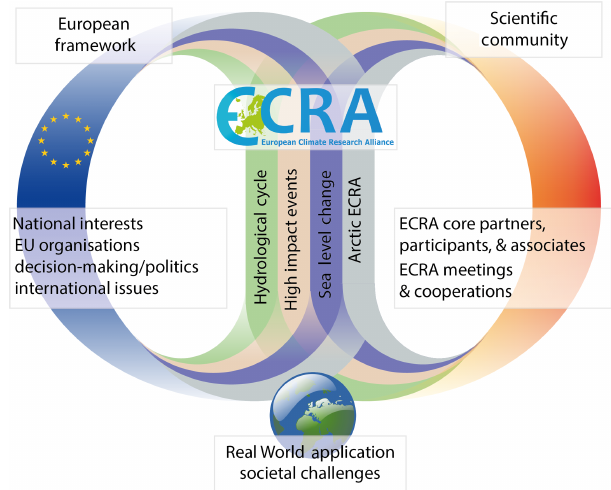
Figure 1. The interplay of ECRA, the European framework, and the scientific actorscape. ECRA’s function is to connect the continu- ous activities of scientific research into the European Union and the other way around. Additionally, issues and criteria of real-world ap- plications are included into the scientific agenda (© ECRA, Earth: Freepngimg.com,